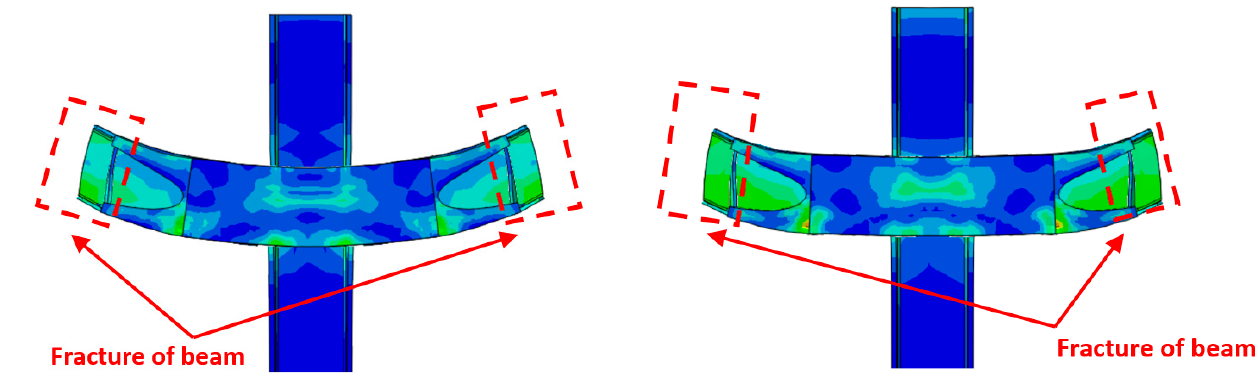
Figure 14. FEM mode of failure for strengthening scheme J-S-S-EX with A572 materials. Table 6. Comparison of FEM results for not welded specimens in terms of different plate thicknesses with two steel grades (A572 &